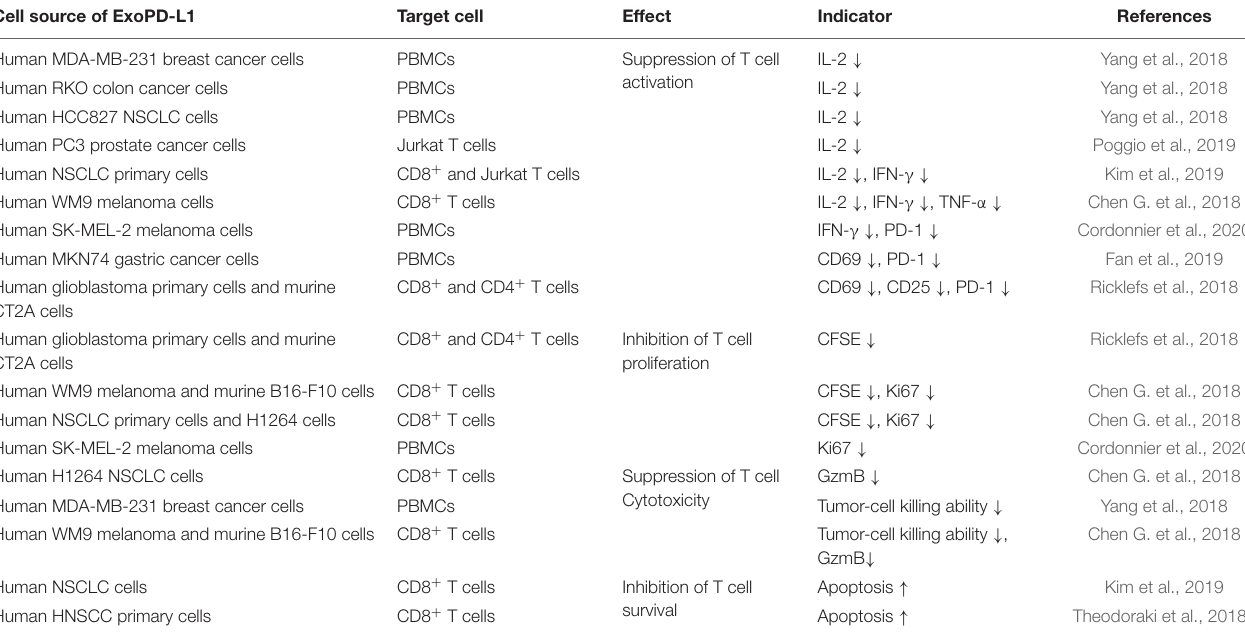
TABLE 2 | The inhibitory effects of tumor cell-derived ExoPD-L1 on T cells in vitro . Cell source of